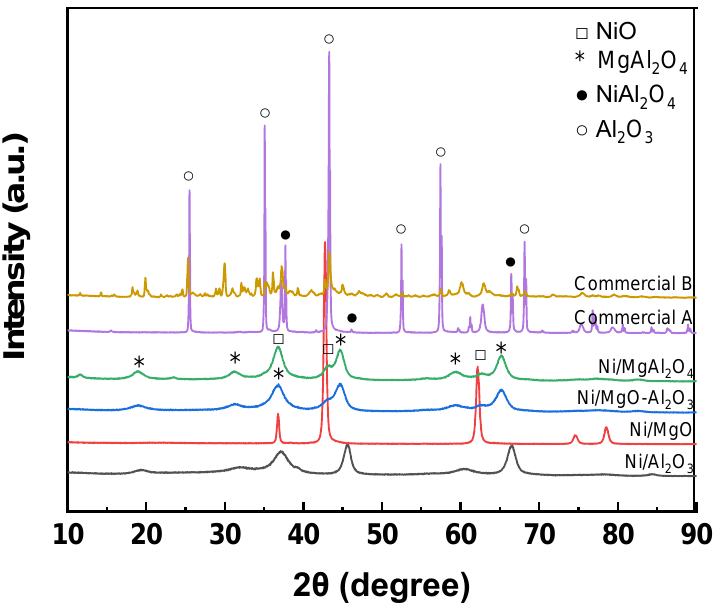
Figure 1. XRD patterns of Ni catalysts with various supports.